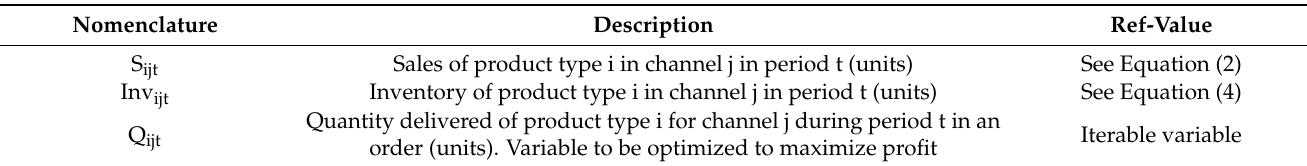
Table 1. Descriptions of the nomenclature of the variables in the